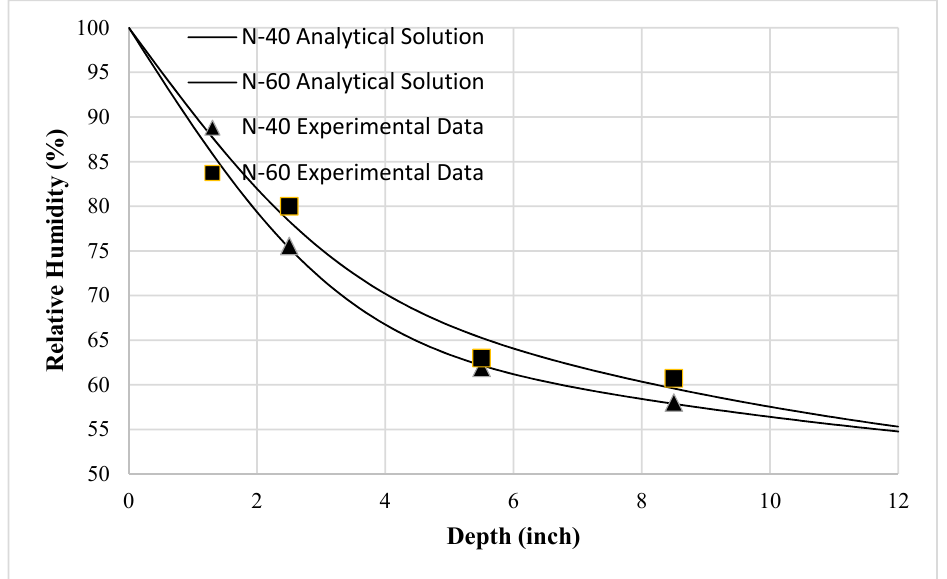
Figure 8. Comparisons of analytical results and experimental data.